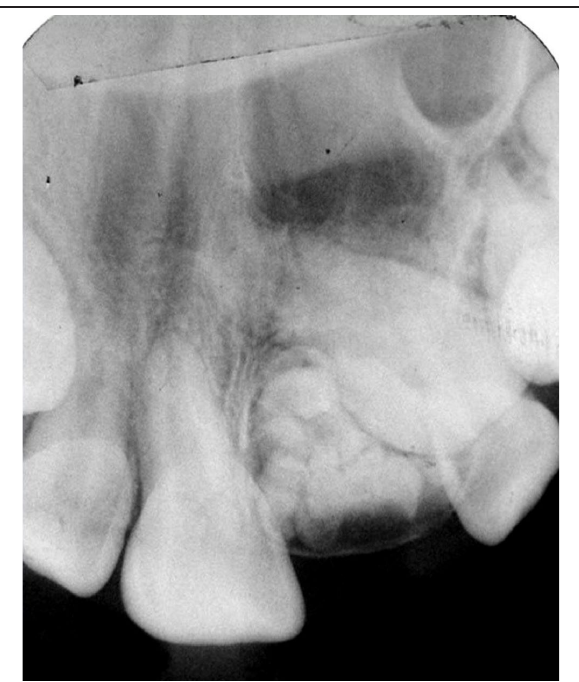
FIGURA 2 – Radiografia